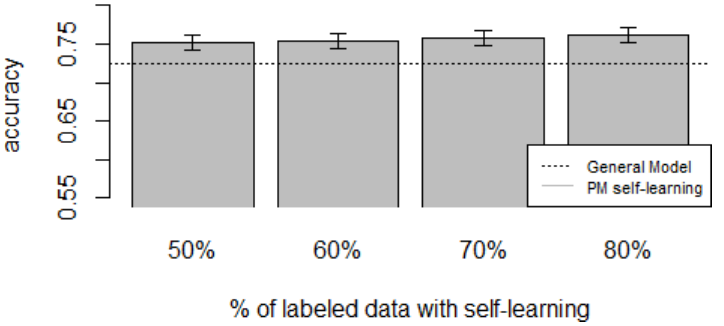
Figure 12. D3: WISDM dataset bar plot for different % of labeled data with self-learning.